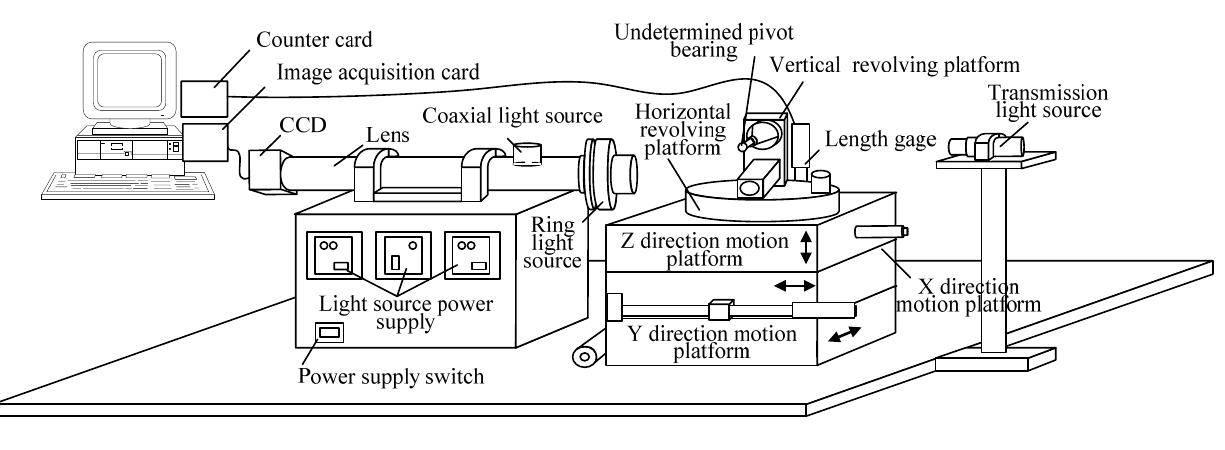
Figure 2. Gyroscope pivot bearing vision detection system.